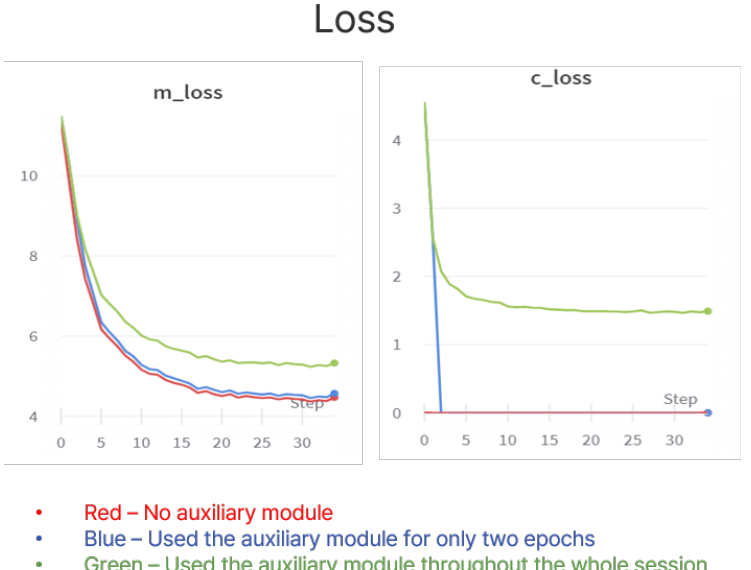
Figure 2. Graphs that show losses depending on the partial use of the module. Because the auxiliary module is disabled after two epochs, the classification loss is zero after the second